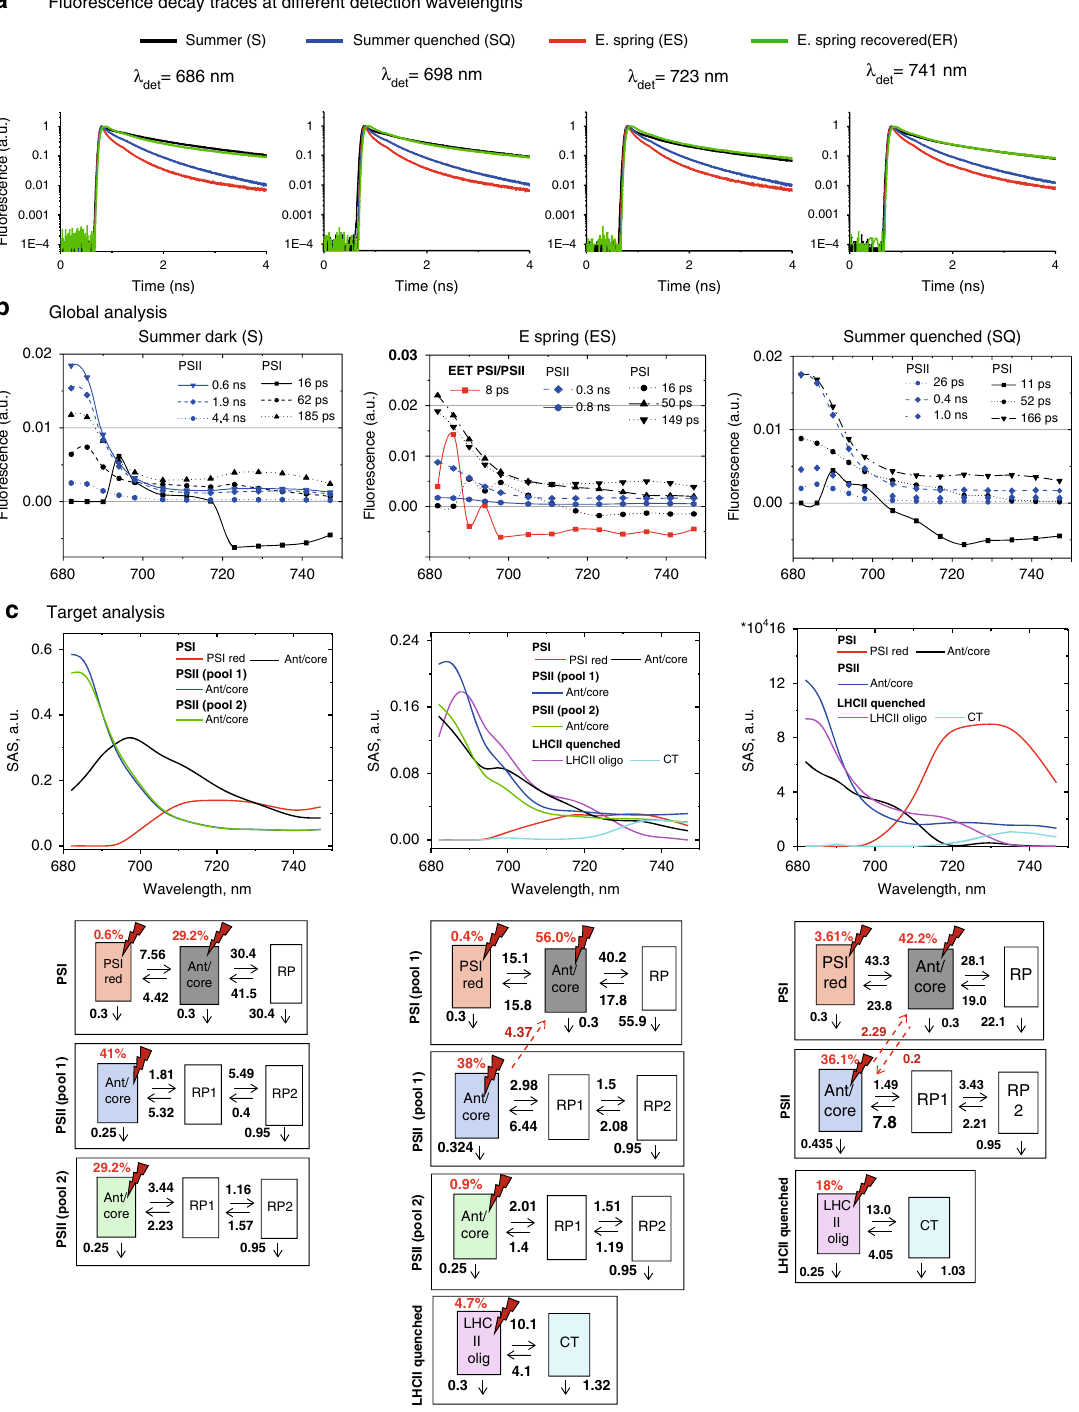
Fig. 3 Time-resolved fl uorescence of intact pine needles measured using TCSPC. ( a ) Fluorescence decay traces measured at − 20 °C and at four characteristic wavelengths: 686 nm (mainly PSII, LHCII contributions), 698 nm (PSII, PSI contributions), 723 nm (mainly PSI contribution), and 741 nm (mainly PSI contribution). ( b ) Global analysis of pine needles in three states: Summer dark (S, dark-adapted summer needles, left row), ES (E.spring needles with “ sustained quenching ” present, middle row), Summer quenched (SQ, right row) ( c ) Kinetic target analysis of pine needles in the three states. See the main text for the explanations. The kinetic target analysis (SAS top, a kinetic model with rate constants in ns-1, bottom) shows the results of the detailed target modeling of the fl uorescence kinetics of pine needles. The rate constants (ns − 1 ) and Species-associated emission spectra (SAS) resulted were determined from global target analysis. Species-associated emission spectra (SAS) resulted from the fi t of the target kinetic model in the corresponding state. Note that fl uorescence decay measurements below 680 nm to detect the decreasing short-wavelength part of the spectra were not possible due to the extremely high scattering of the pine needles. This has no effect however on the ability to distinguish the various lifetime components kinetically and